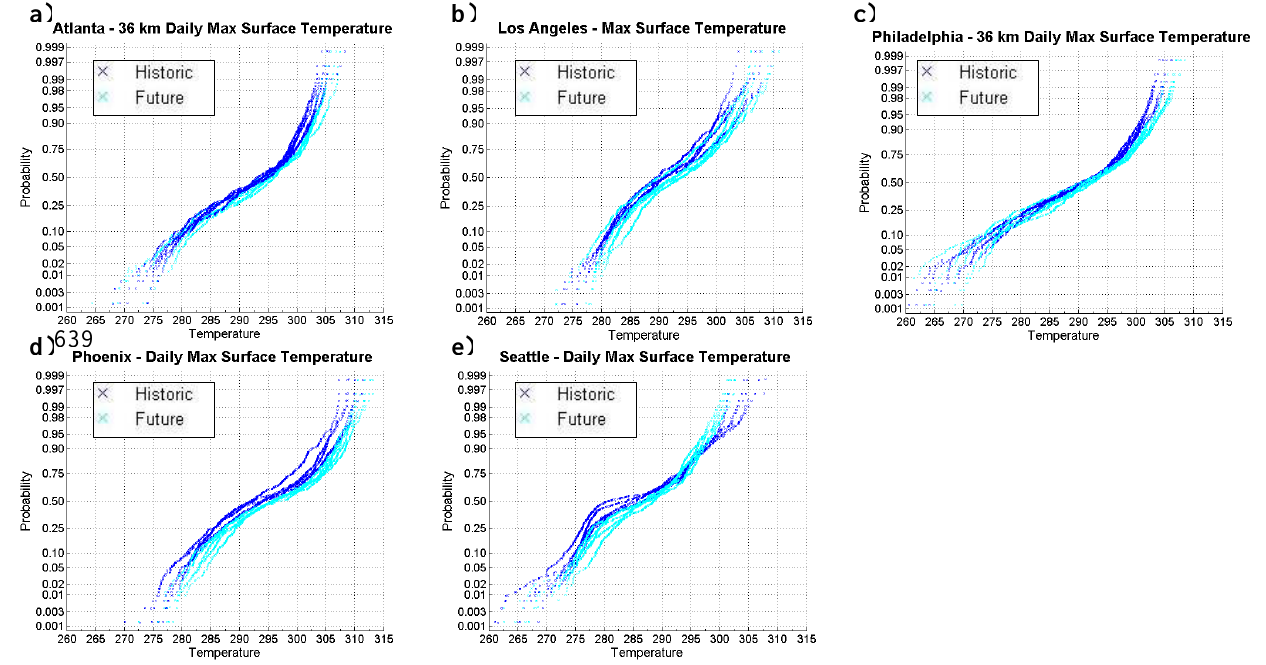
Fig. 8. Empirically determined cumulative distribution of 36km historic (2006–2010) and future (2048–2050) maximum daily 1h average temperature at major US cities: (a) Atlanta (b) Los Angeles (c) Philadelphia (d) Phoenix and (e)